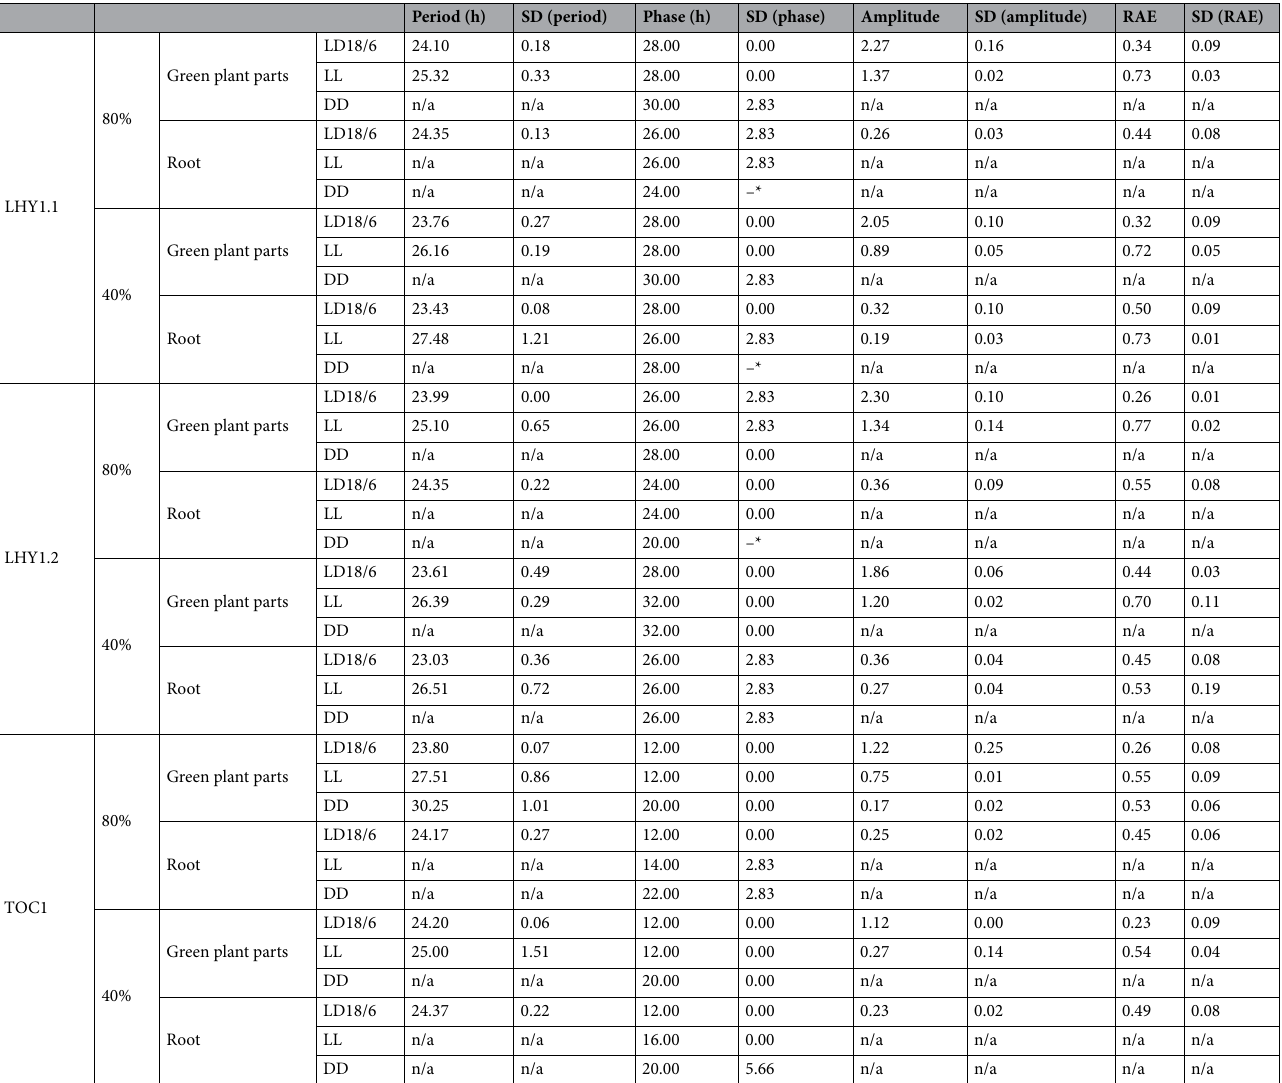
Table 1. Periods, phase and amplitudes and RAE values of time course gene expression of central loop genes: LHY1.1 (Bradi3g16515.1), LHY1.2 (Bradi3g16515.2) and TOC1 (Bradi3g48880.1) in green plant parts and roots. Period and RAE values were estimated with BRASS software from the whole dataset (ZT2 to ZT78) for the individual time course expression curves measured by qRT-PCR. Amplitudes were calculated from the 2nd peak of the curve for LHY1.1 and LHY1.2 , while the 1st peak was taken into account for TOC1 . Phase: time of expression maxima with reference to daybreak. Amplitude: twice the average distance from the mean expression maxima. RAE: relative amplitude error; Fourier fit to experimental data varying between 0 (perfect fitted rhythm) and 1 (rhythm not significant). Values are means ± SD from two biological replicates (except *, where only one dataset was appropriate for analysis). n/a: no data result from data analysis. LD: 18:6 light: dark cycles. LL: 24:0 light. DD: 0:24 dark. 80%: well-watered conditions; 80% relative soil water content. 40%: drought stress conditions; 40% relative soil water